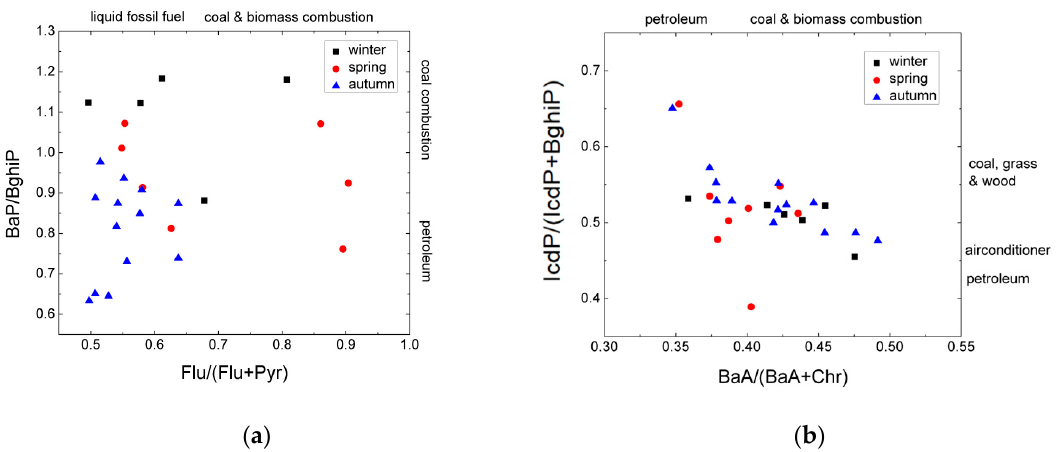
Figure 4. Results of diagnostic ratio method. ( a ) Bap/BghiP and Flu/(Flu + Pyr) ( b ) IcdP/(IcdP + BghiP) and BaA/(BaA + Chr).